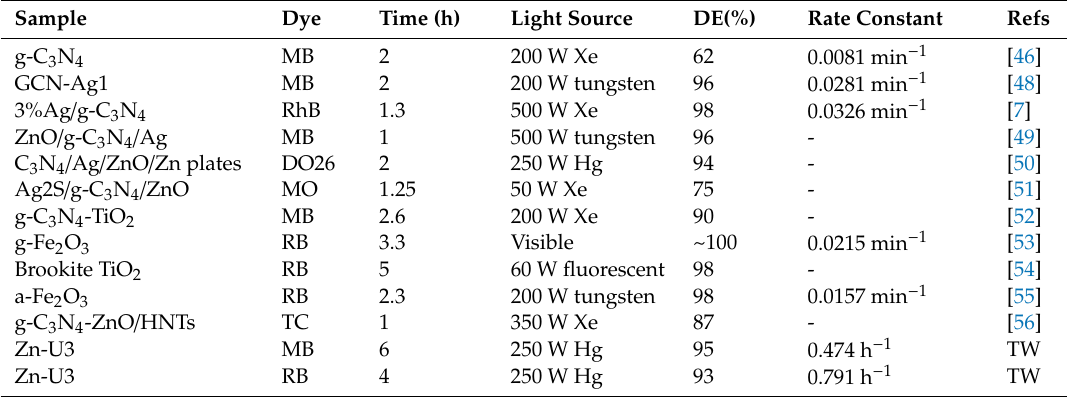
Table 3. Table showing comparison of photocatalysts and dyes with previously published works.